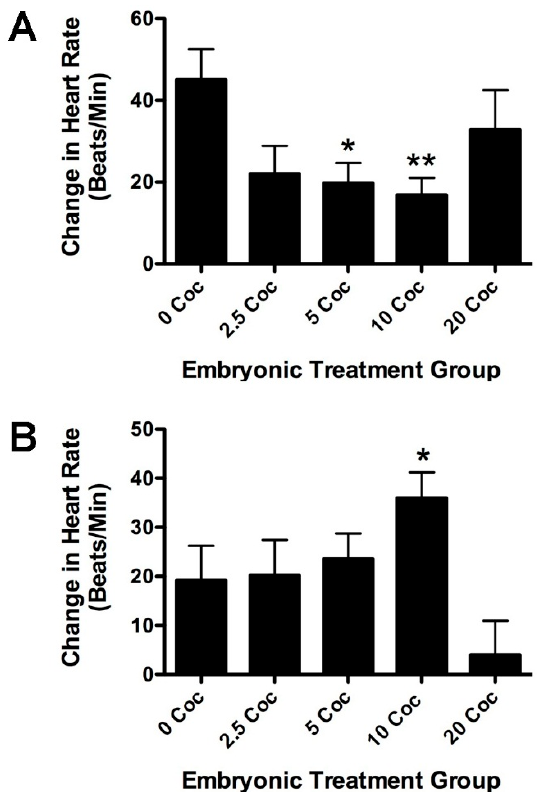
Figure 4. Embryonic cocaine exposure alters cardiovascular sensitivity to isoproterenol ( A ) and cocaine ( B ) in longitudinal adults. The heart rate of longitudinal adults was determined by measuring the ECGs. Baseline heart rate in longitudinal adults treated with cocaine as larvae was no different from untreated controls (Table 2). However, the response to isoproterenol, a ß1 agonist, was lower in longitudinal fish that were treated with cocaine as larvae than in fish that did not receive cocaine. The histogram in panel A shows the isoproterenol-induced change from baseline heart rate in one of three experiments all showing similar results. The effect of larval pre-exposure to cocaine on the adult isoproterenol response was U-shaped, with a maximal inhibition seen in fish previously treated with 10 mg/L cocaine (Error bars indicate ± SEM, * indicates p < 0.05, ** indicates p < 0.01, compared to untreated controls, n = 7 for each condition). Longitudinal fish from the different embryonic treatment groups were also challenged with 5 mg/L cocaine and their ECGs measured. The histogram in panel B shows the effect of larval pre-exposure to cocaine on subsequent adult cardiovascular response to the drug. The response by the different longitudinal groups is bell-shaped, with a maximal effect seen in fish pre-exposed to 10 mg/L cocaine as larvae (Bars indicate ± SEM, * indicates p < 0.01 when compared to fish pre-exposed to 20 mg/L, n = 18 for 0 and 20 mg/L cocaine, n = 16 for 2.5 and 10 mg/L, and n = 15 for 5 mg/L cocaine).